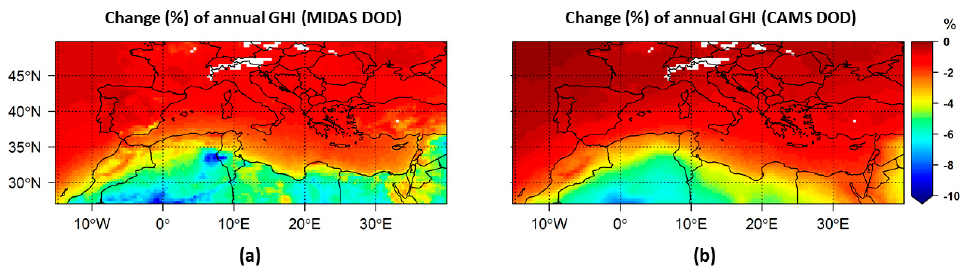
Figure 7. Change (in %) of the mean annual integral of GHI due to the presence of dust under ( a ) MIDAS DOD and ( b ) CAMS DOD. Blank grid points are those that did not fulfill the criterion of at least 20% data availability on annual basis.